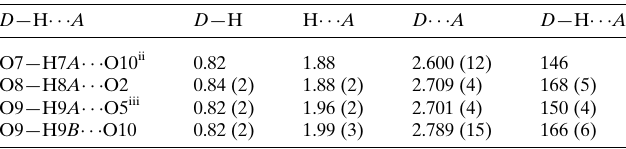
Table 2 Hydrogen-bond geometry (A˚ , (cid:4) ).